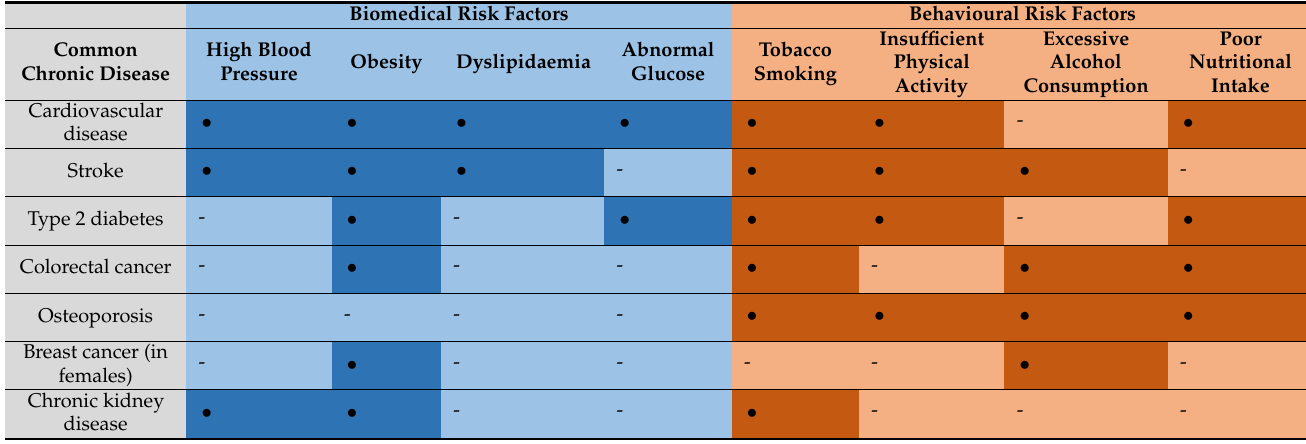
Table 1. Associations between common chronic diseases and chronic disease risk factors (biomedical and